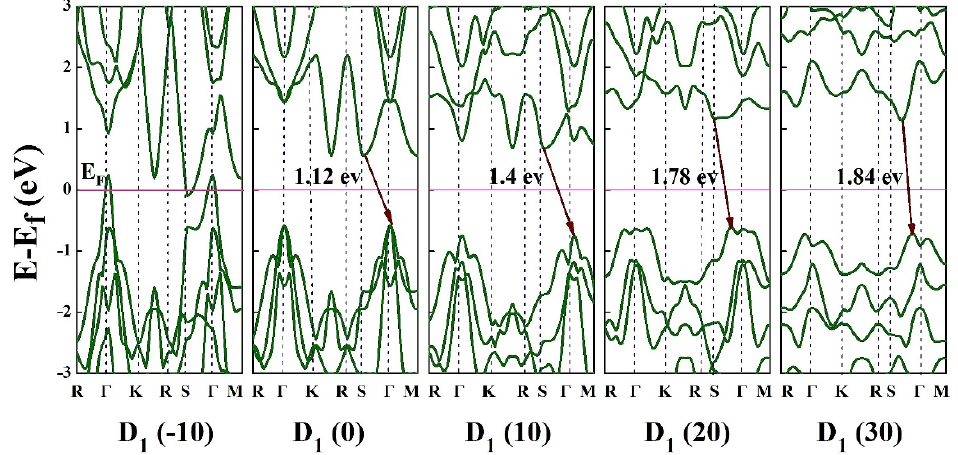
Figure 7. Band structure of HfS 2 monolayer under the uniaxial strains in the range of − 10% to 30% along x direction. The Fermi level is set to